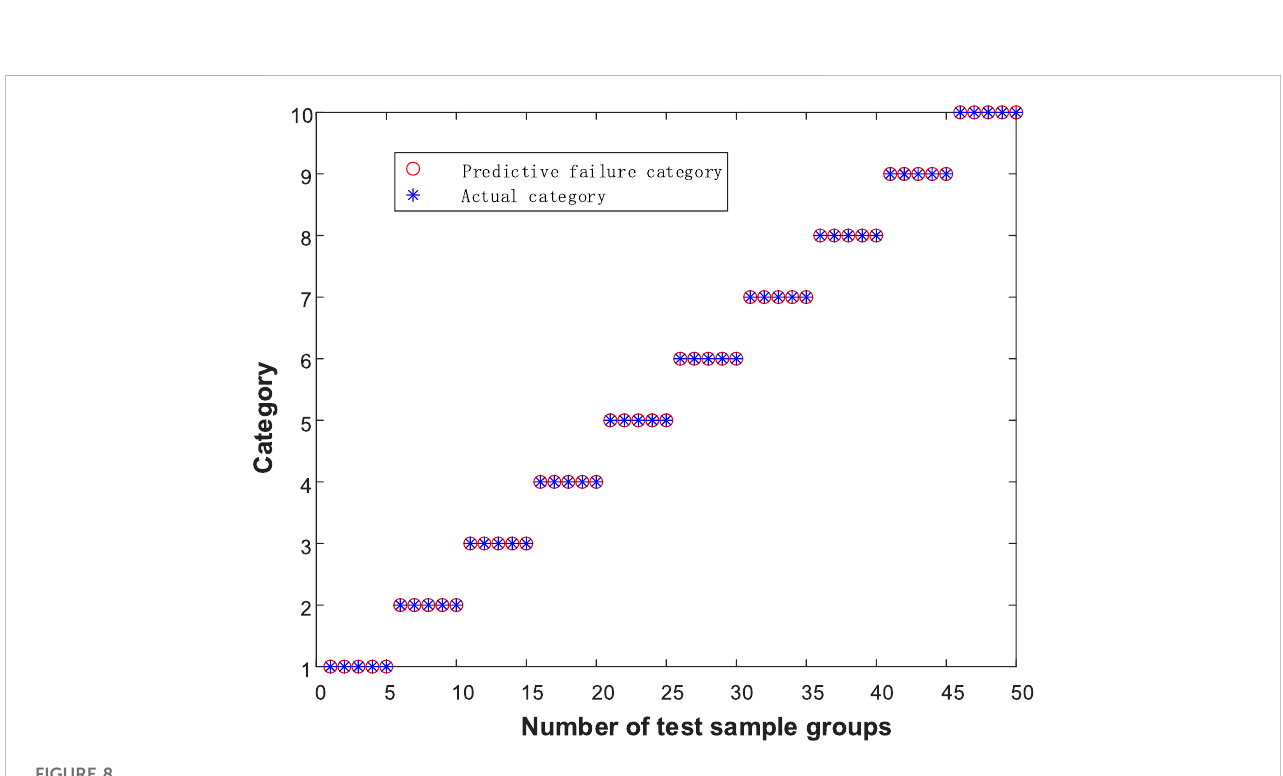
FIGURE 8 The predictive failure categories and actual categories of the test